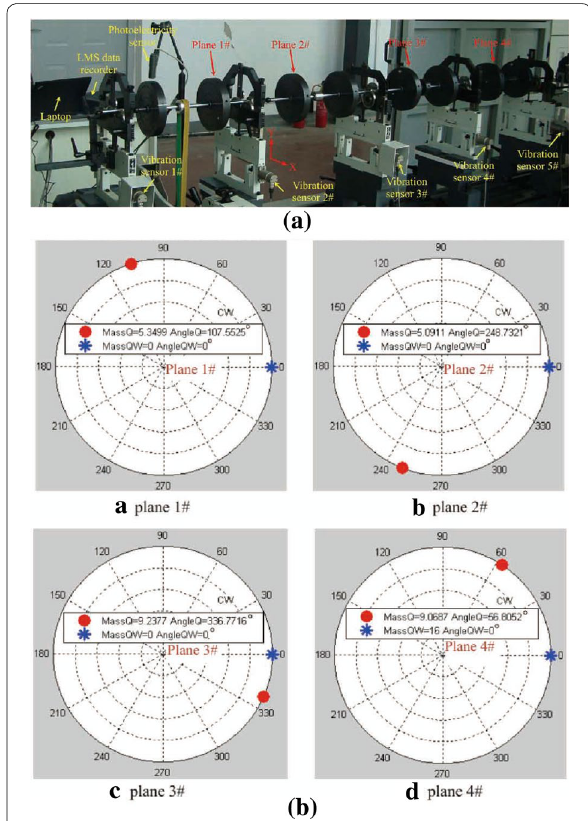
Figure 19 Imbalance location results of Bin et al. [69]: a Experimental device; b Imbalance location